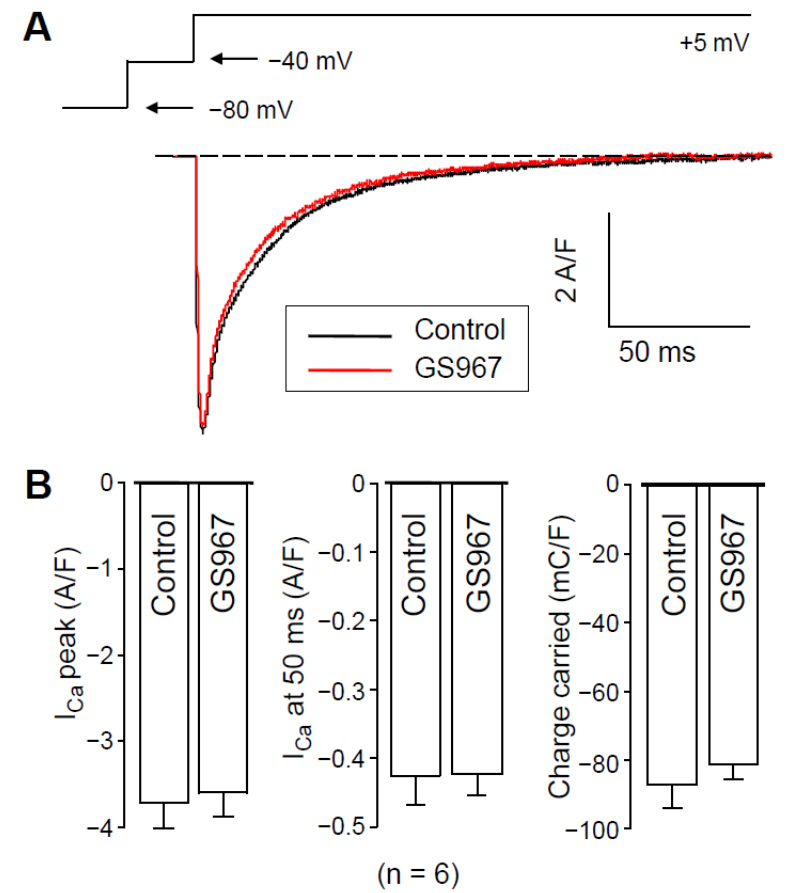
Figure 3. Effects of 1 µM GS967 on I Ca under conventional voltage-clamp conditions using test pulses of 200 ms duration clamped to +5 mV from the holding potential of − 80 mV following a 15 ms duration prepulse to − 40 mV. ( A ) Representative superimposed analog I Ca records. ( B ) Average I Ca densities measured as peak currents, or 50 ms after beginning the pulse and I Ca integrals obtained in six myocytes. Columns and bars represent mean ± SEM values.